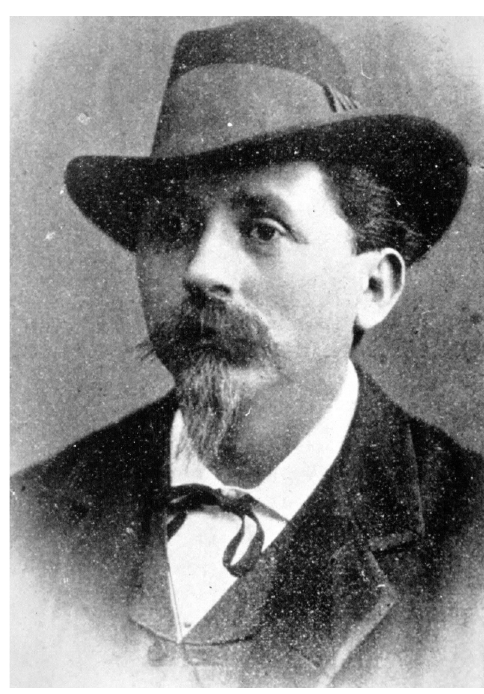
Fig. 1. A portrait of Pietro Tacchini